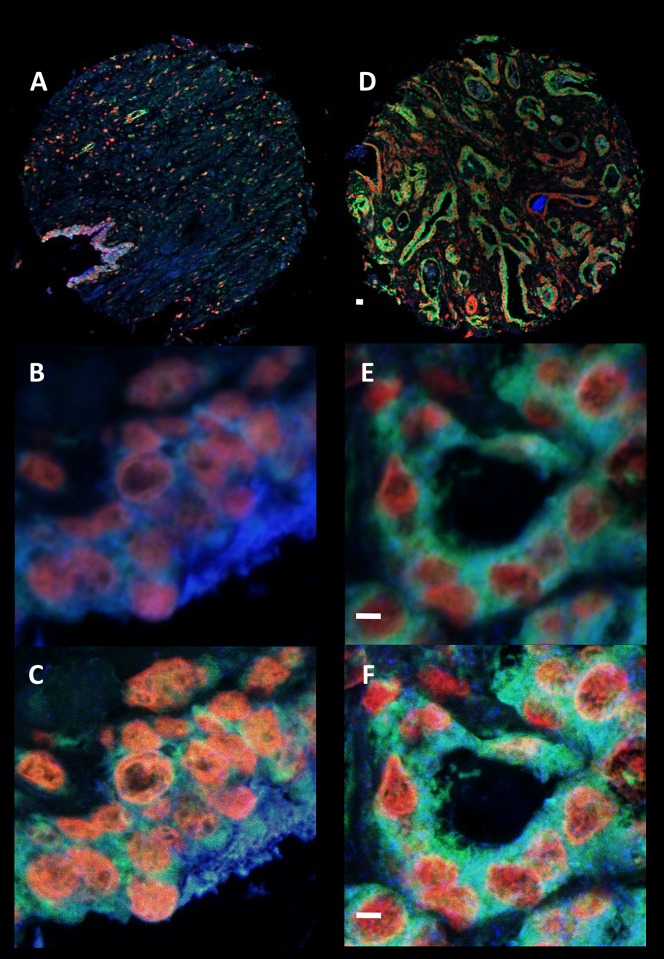
RPS19, RPS21, and RPS24 protein expression using immunofluorescence.Representative images of the co-expression of RPS19 (Cy3- Red), RPS21 (FITC- Green), and RPS24 (Cy5- Blue) which was analysed in both malignant (D, E, F) and non-malignant (A, B, C) prostate tissue. Whole tissue cores (A and D) were imaged on an Olympus IX81 confocal system at low magnification. Intensity of fluorescent signals were optimised at the beginning of each study to prevent oversaturation for each fluorophore. Quantification of co-localization was carried out on images gathered from a randomly selected area of the tissue core using a 40x objective zoom (E is malignant and B is non-malignant) on an Olympus IX81 confocal system. The image was further magnified using a 6x digital zoom. Each image was then deconvolved (C and F) and the GIC was calculated using Huygens software (see Materials and methods). Scale bar = 10 μm.